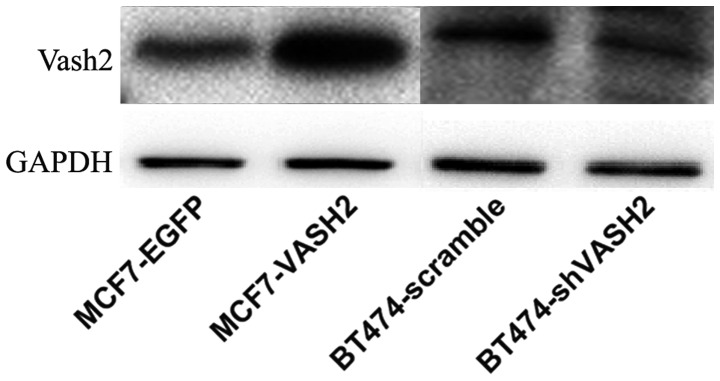
VASH2 expression in stably transfected MCF-7 and BT474 cells. MCF-7 cells were transfected with a vector expressing EGFP (MCF7-EGFP) or VASH2 (MCF7-VASH2); BT474 cells were transduced with scrambled shRNA (BT474-scramble) or VASH2-targeting shRNA (BT474-shVASH2). The level of VASH2 protein in each cell type was assessed by immunoblotting. GAPDH, glyceraldehyde-3-phosphate dehydrogenase; VASH2, vasohibin-2; EGFP, enhanced green fluorescent protein; shRNA, short hairpin RNA.